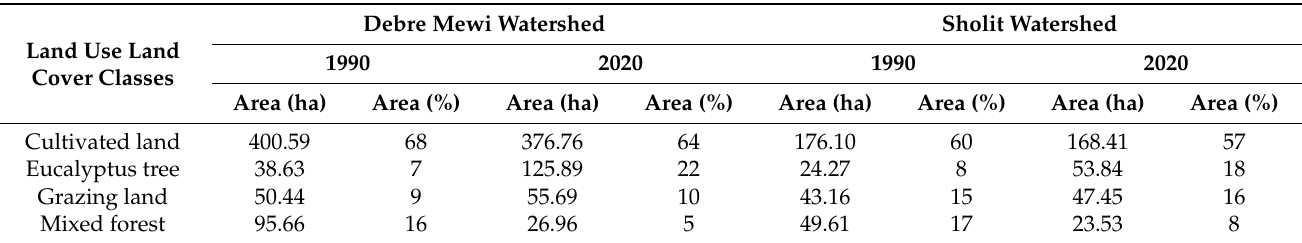
Table 6. Land use/land cover change in Debre Mewi and Sholit watersheds over the last three decades (1990 to